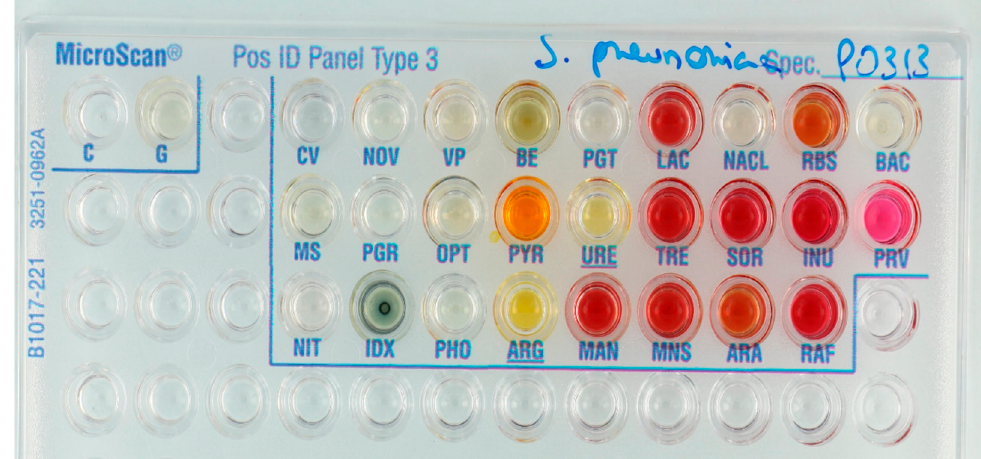
Figure 3. Streptococcus pneumoniae clinical isolate incorrectly identified as Gemella species; PNP- β - D-Glucuronide test (PGT) was considered negative (any shade of yellow = positive). A positive result for PGT would have led to correct identification of S. pneumoniae with a probability score of 94.79%. Only indoxyl phosphatase (IDX) test was positive in this panel.